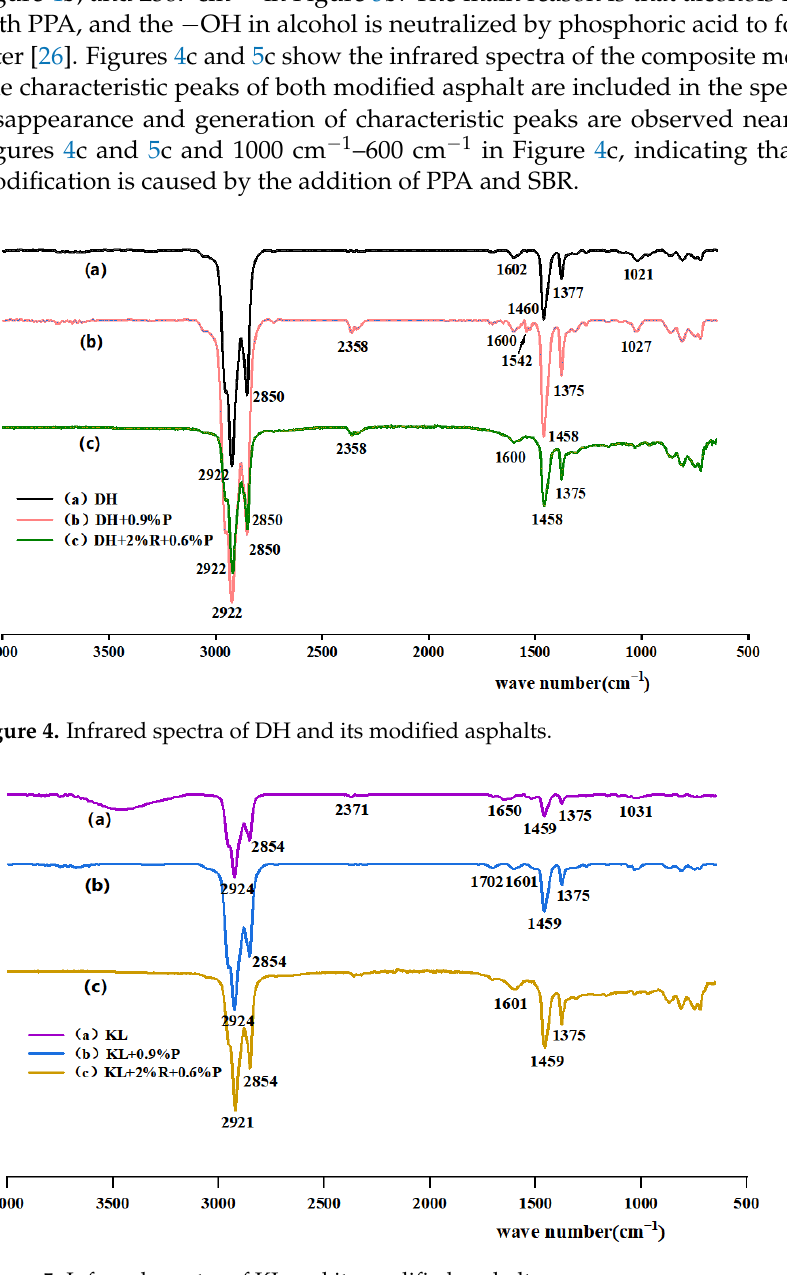
Figure 5. Infrared spectra of KL and its modified asphalts.